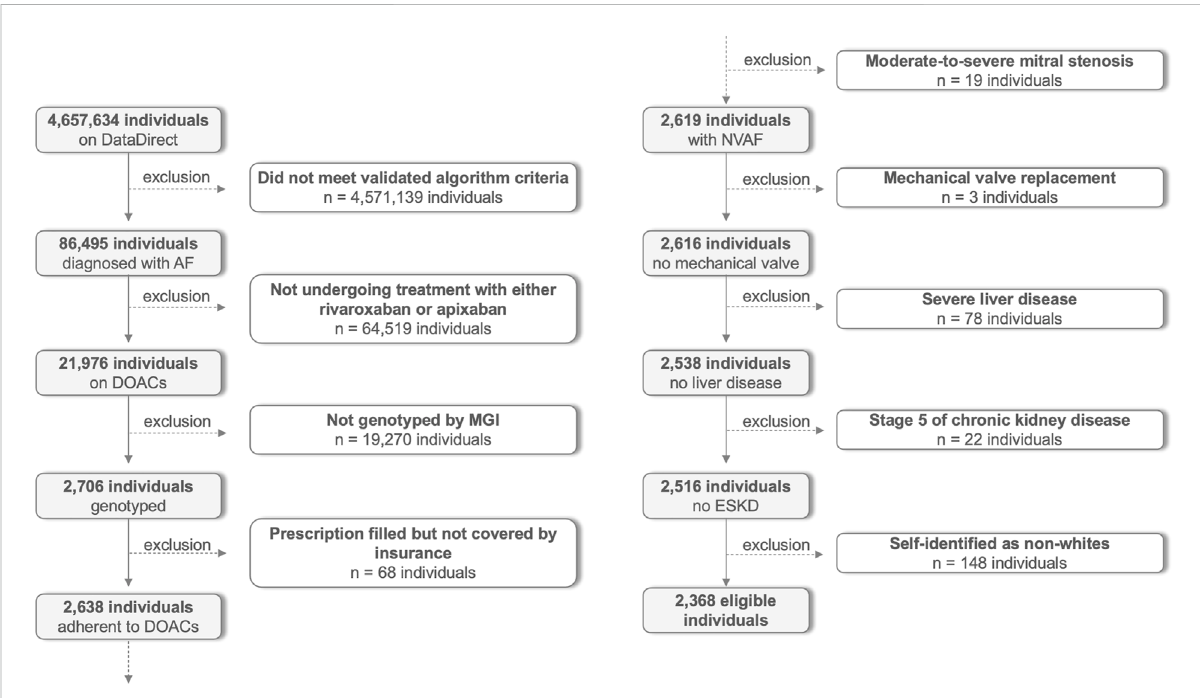
FIGURE 1 Flowchartwith participants ’ selection. AF: Atrial fi brillation; DOACs: Direct oralanticoagulants; MGI: Michigan GenomicsInitiative; NVAF: Non- valvular atrial fi brillation; ESKD: End-stage kidney